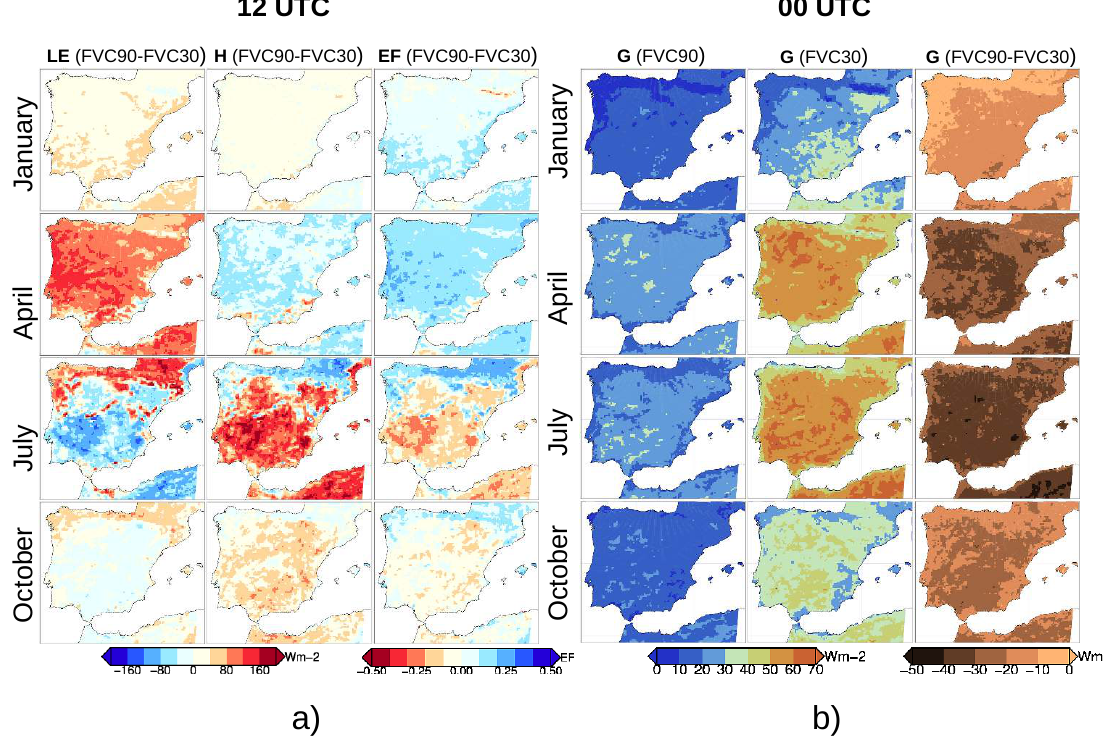
Figure 4. ( a ) Differences of LE (W/m 2 ), H (W/m 2 ) and EF between experiments FVC90 and FVC30 at 12 UTC. ( b ) G (W/m 2 ) for experiments FVC90 and FVC30 and its differences at 00 UTC. Monthly means of January, April, July and